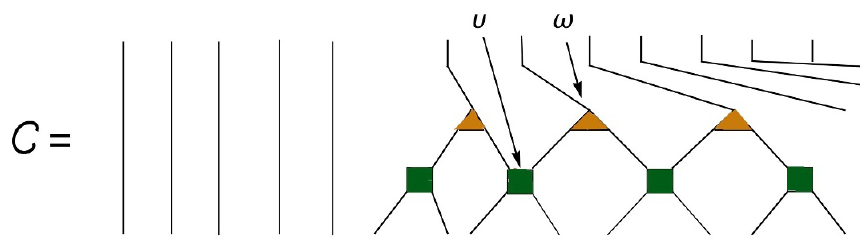
Figure 3 . The tensor chiraleon for constructing WCFTs. Note that the yellow triangles are gates that are combination of unitary disentaglers and chiraleons. So one could consider the two layers are combined together.